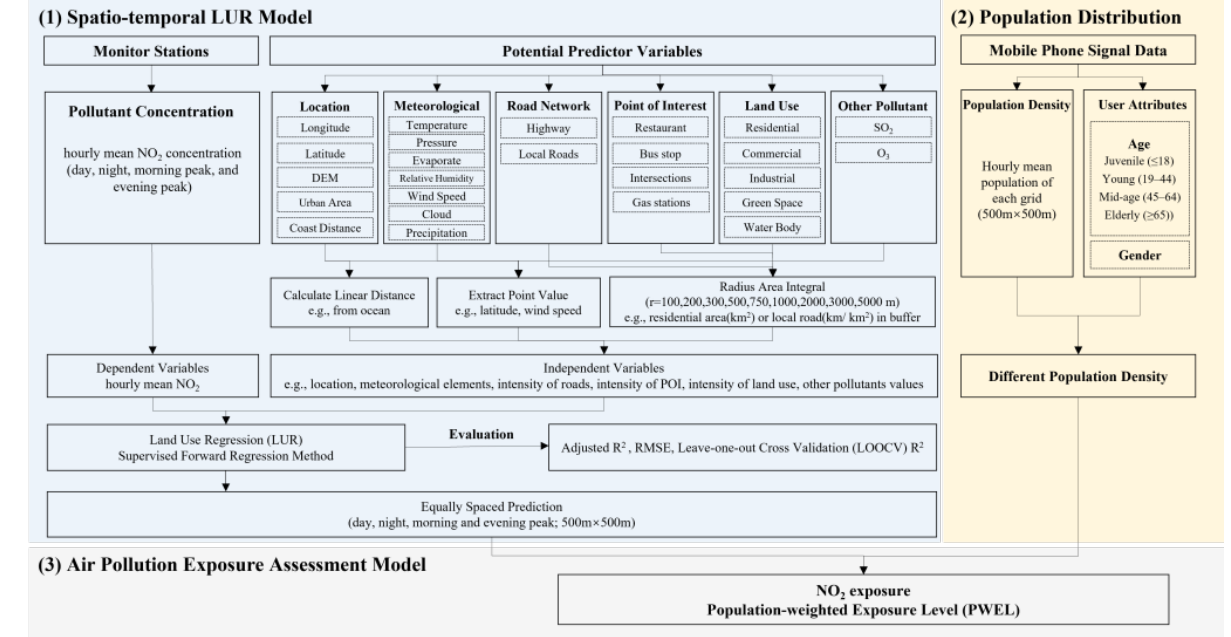
Figure 1. Research flow chart.